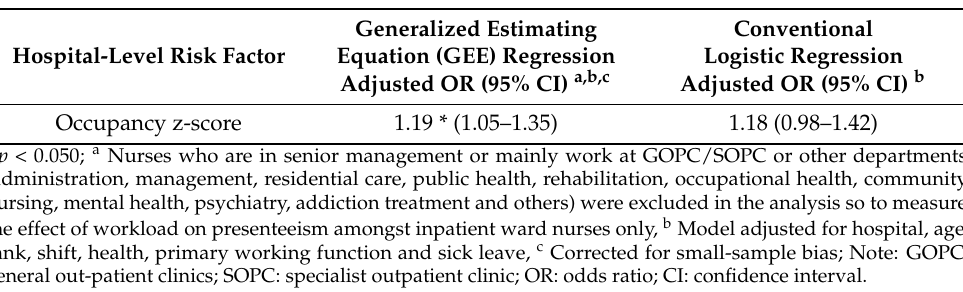
Table 4. Conventional and generalized estimating equation results on presenteeism frequency amongst nurses for hospital level characteristics.